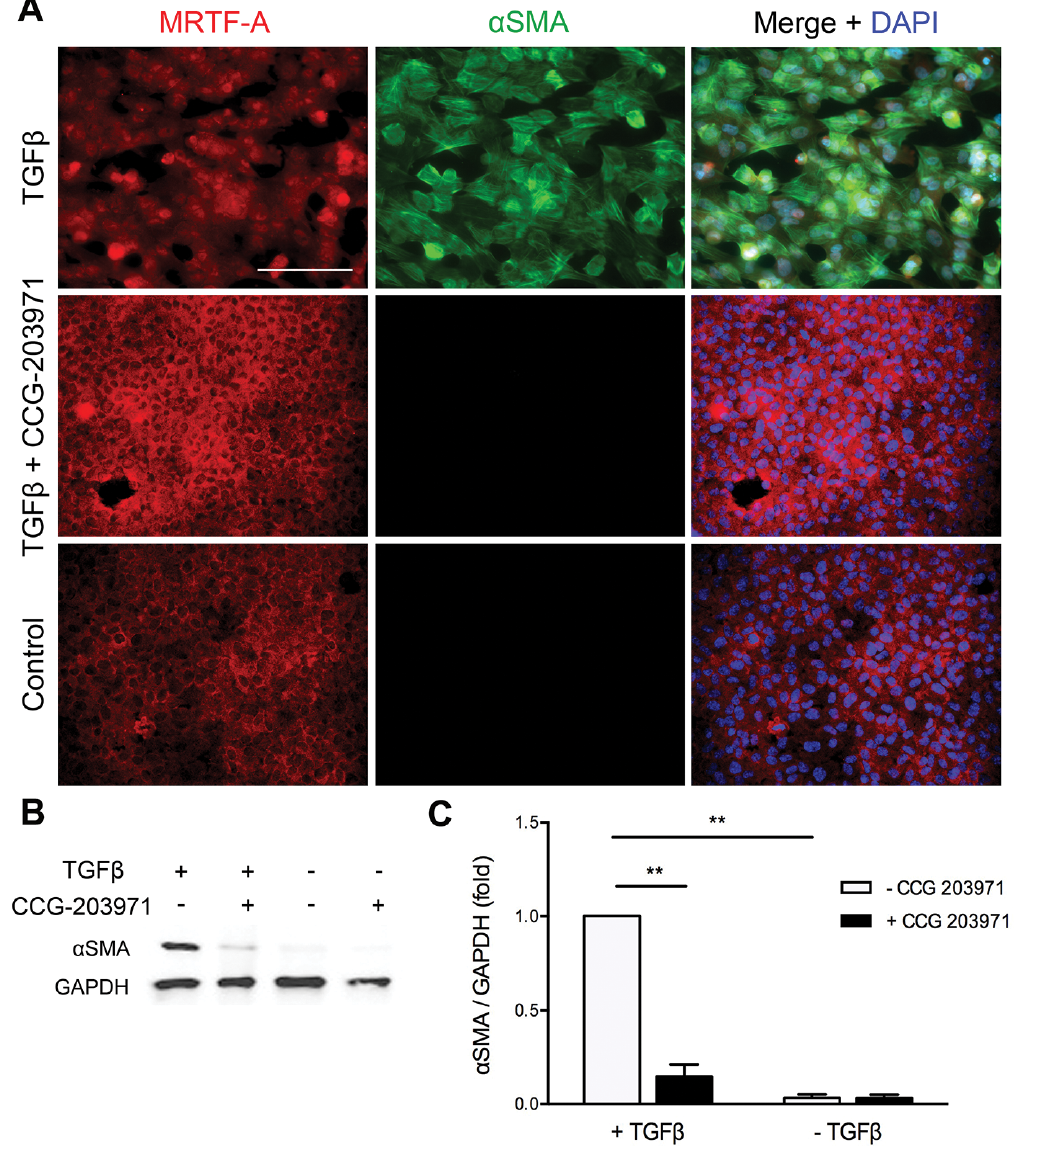
Figure 6. CCG-203971 prevents TGF β -induced actin polymerization and α SMA expression. (A) Lens explants were treated with TGF β (4 ng/mL) in the presence and absence of CCG-203971 (5 μ M). Fixed explants were costained for MRTF-A and α SMA and mounted in medium with DAPI to colocalize nuclei. (B) Pooled lens explant lysates (n ≥ 5 explants per sample) were probed for α SMA and GAPDH as loading control. (C) Densitometric quantification of α SMA/GAPDH indicating the fold reduction in α SMA expression normalized to TGF β -treated explants. Data are expressed as means ± SEM from three separate experiments (** p <.0001). Scale bar = 100 μ m